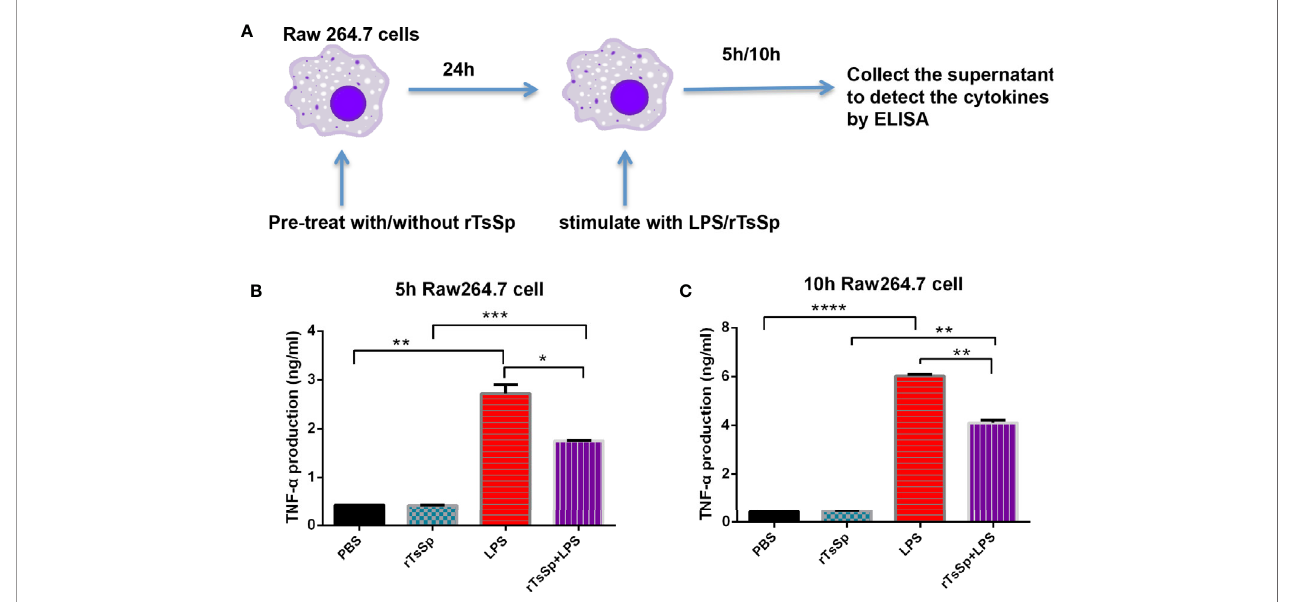
FIGURE 3 | rTsSp reduced TNF- a production by macrophages. (A) Raw 264.7 cells were pre-treated with/without rTsSp 1 day before or at the same time when stimulated with LPS; after 5 or 10 h stimulated, the supernatant was collected; the TNF- a production of the supernatants of (B) 5 h and (C) 10 h were detected by ELISA. The data shown are means ± SEM from one of three separate experiments performed showing similar results. * P < 0.05, ** P < 0.01, *** P < 0.001, **** P <